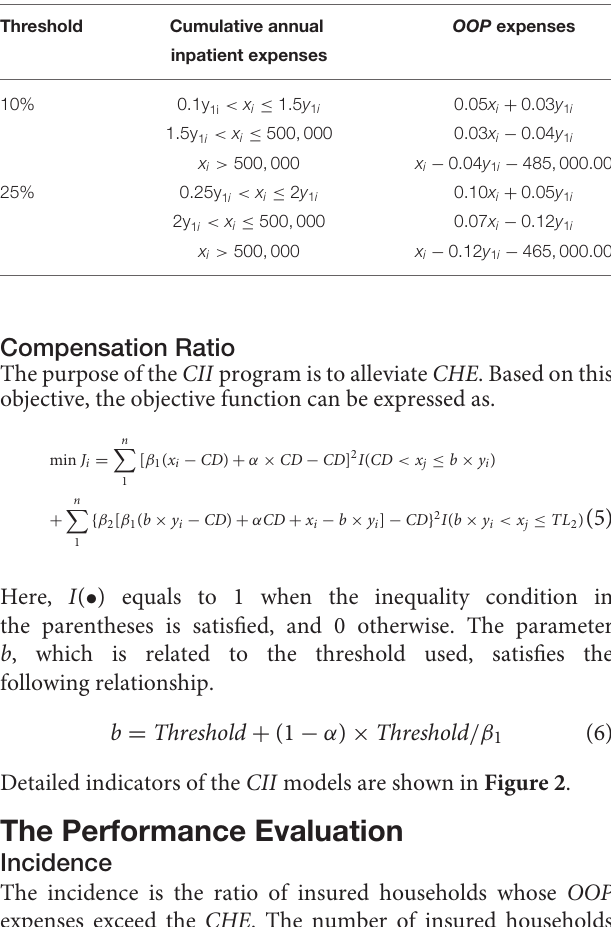
TABLE 4 | Household cumulative OOP expenses in the basic approach. TABLE 5 | Performance evaluation of the CII model in the basic approach.